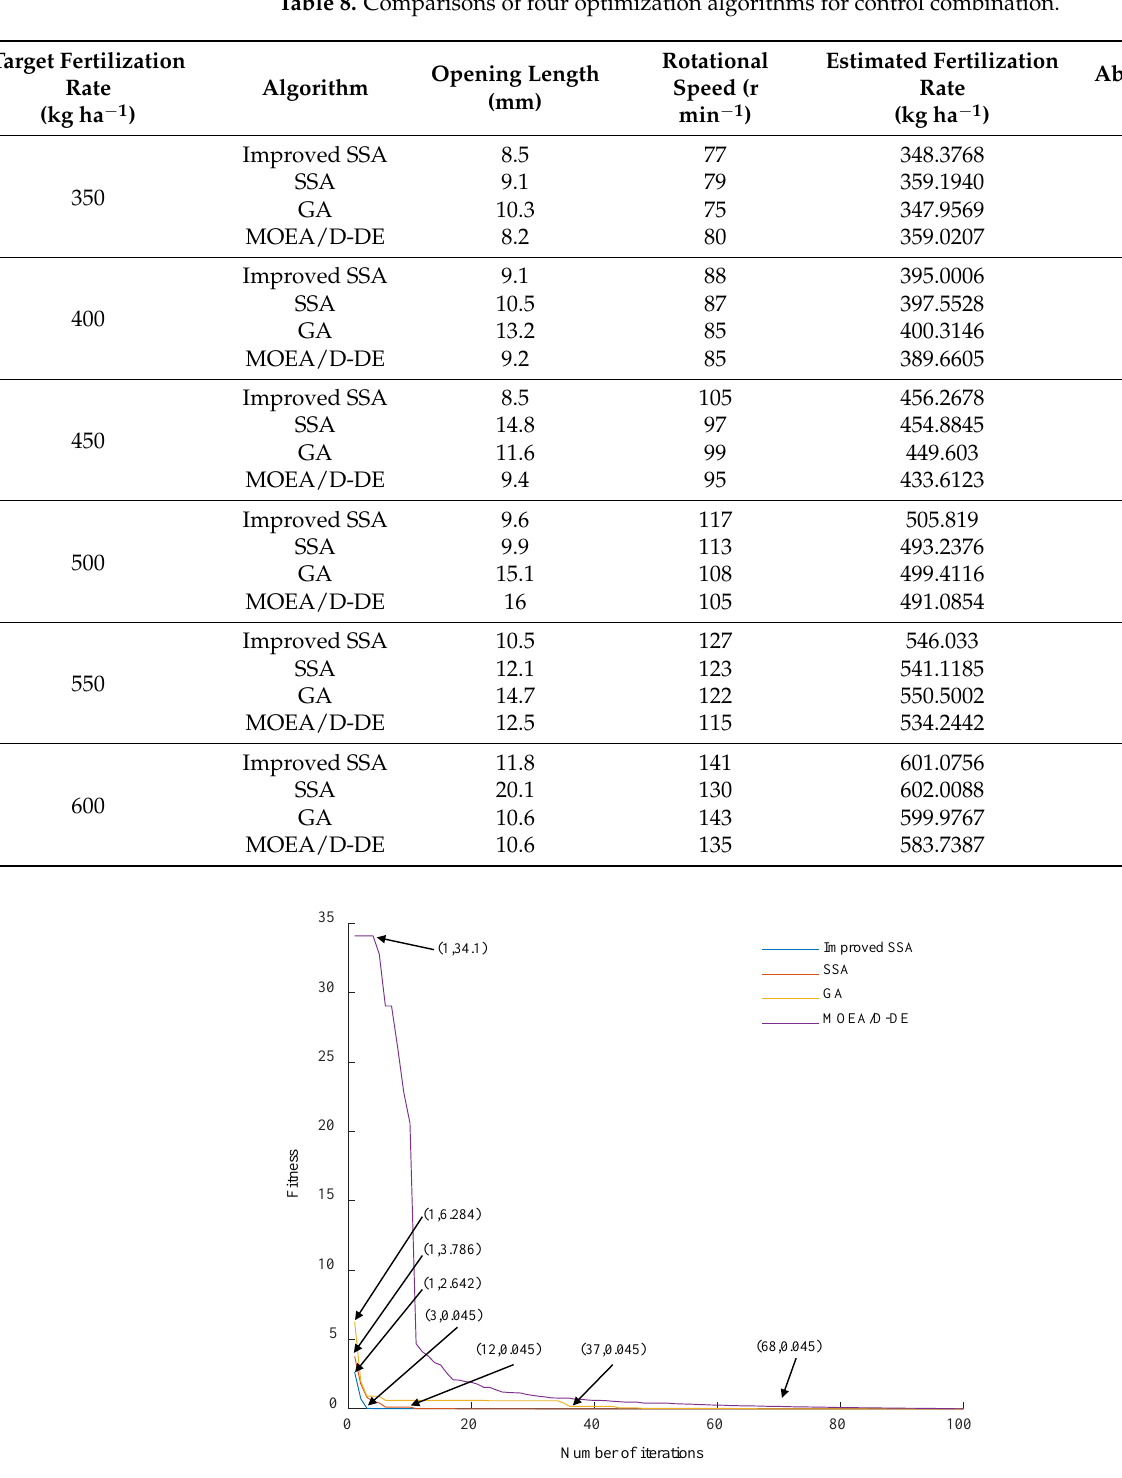
Figure 6. Iteration process of decision-making algorithms.